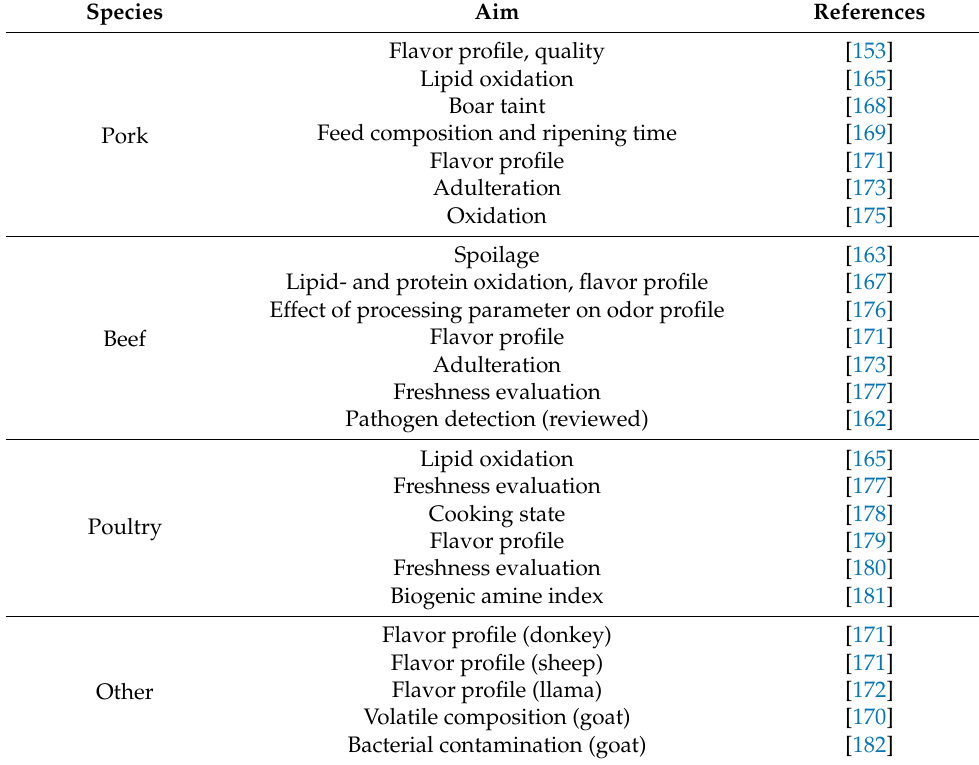
Table 4. Overview of studies where meat volatiles and odor were detected by electronic